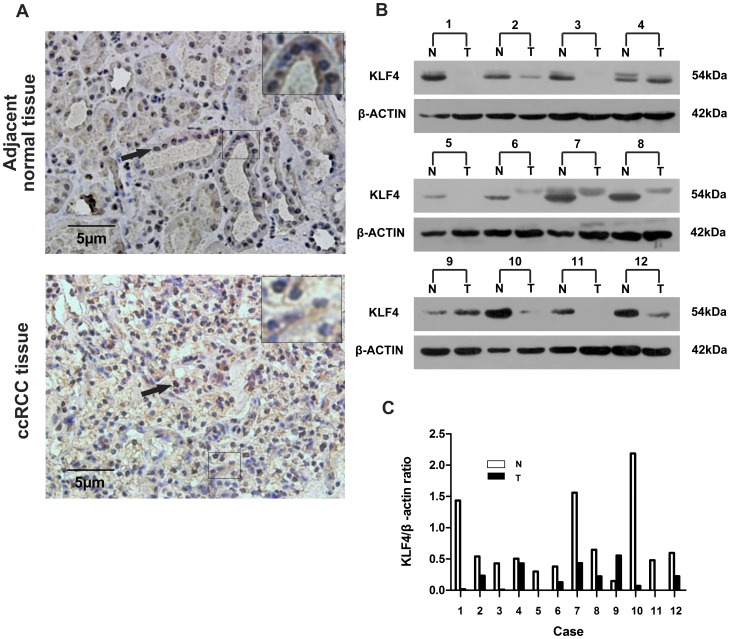
KLF4 protein expression was suppressed in primary ccRCC tissues.(A) Representative immunostaining of KLF4 expression in human ccRCC tissues and corresponding adjacent kidney tissues. Arrows indicate a positive nuclear staining for KLF4. (B) Western blot showing KLF4 expression in ccRCC tissues (T) and corresponding adjacent kidney tissues (N) from ccRCC patients. β-actin is used as a loading control. (C) KLF4 in each specimen was quantified by densitometric analysis using Adobe Photoshop. KLF4 expressions in each sample were normalized with those of β-actin by determining the KLF4:β-actin ratio (K/β-actin). N: normal; T: tumor.